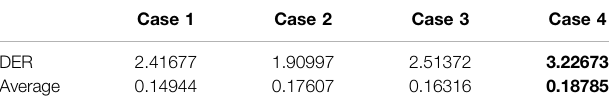
TABLE 2 | Dynamic comprehensive evaluation results of each planning case ( V + (cid:1) 0 . 5, V − (cid:1) 0 .